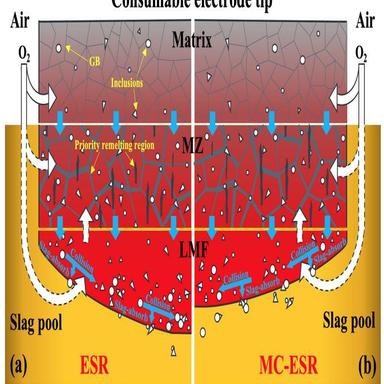
Schematic diagrams of microstructure evolution and motion behavior of inclusions in electrode tip in this study, (a) Without ASMF, (b) With ASMF, respectively.